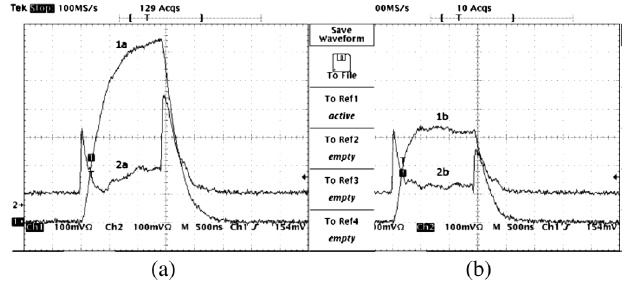
FIG. 5. Beam loading compensation. (a) rf power in the gun (1a) and reflected power (2a) when no beam is present. (b) rf power in the gun (1b) and reflected power (2b) when the beam is present.